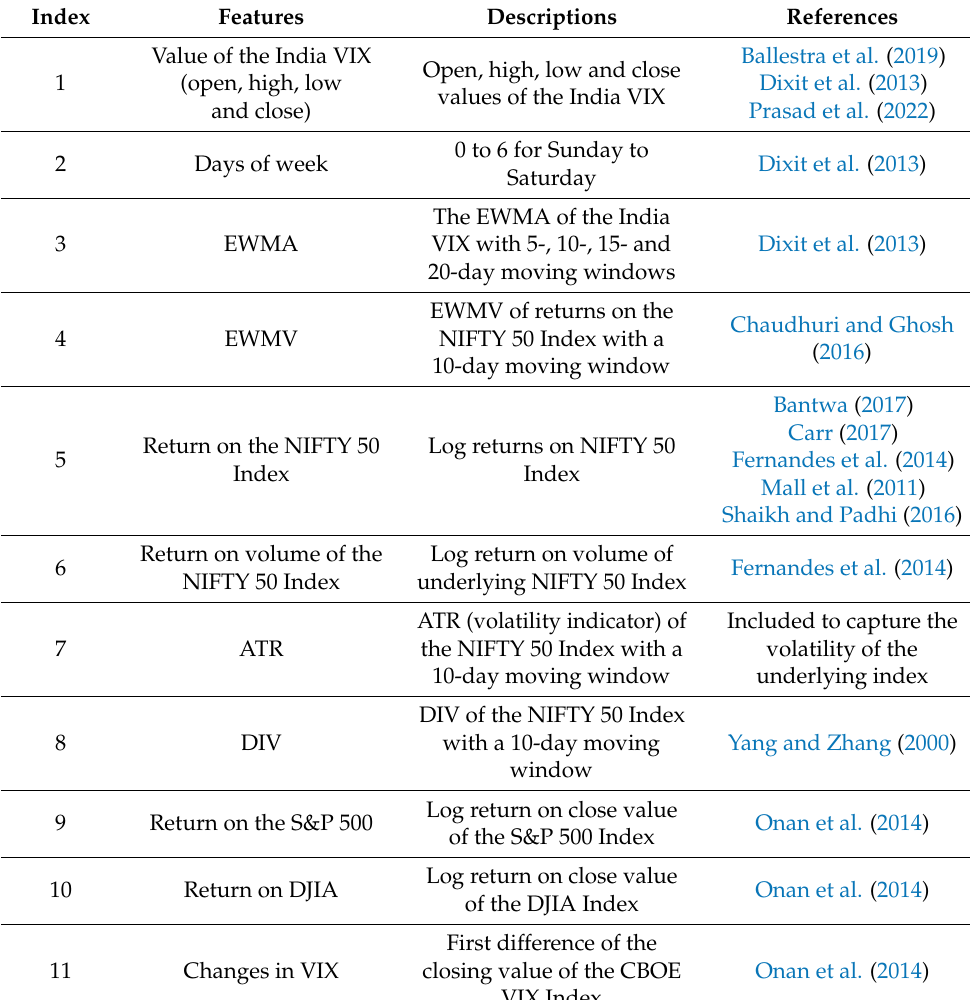
Table 4. List of feature